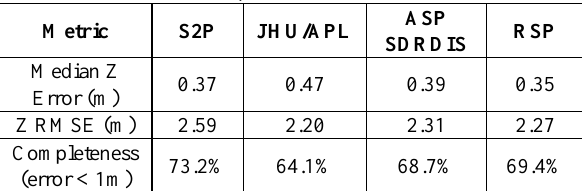
Table 1 Stereo accuracy and completeness metrics for